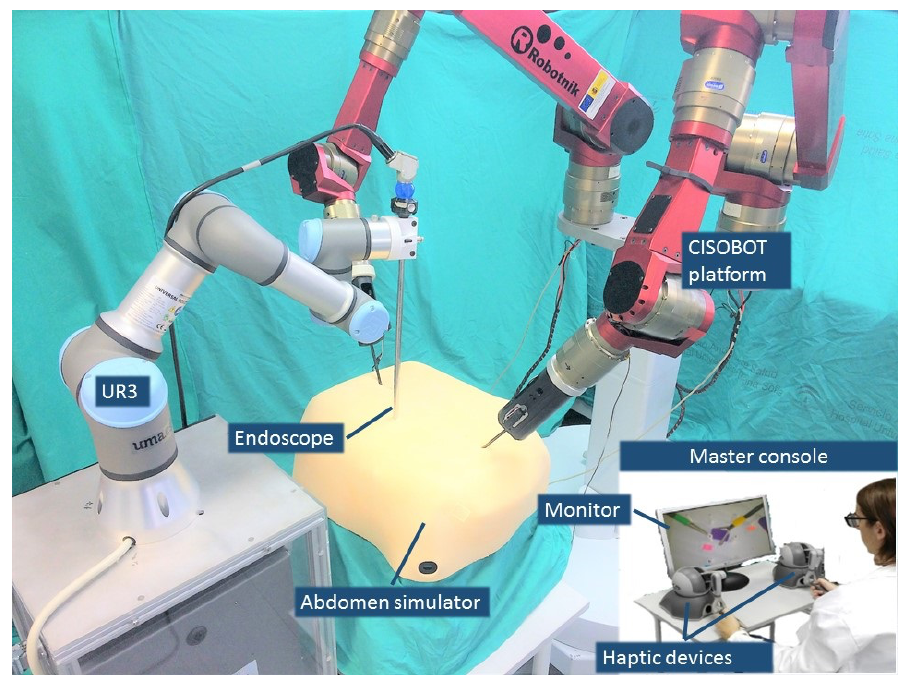
Figure 3. Experimental surgical robotic platform. It was composed of a teleoperation master console, an endoscope that was handled by a UR3 robot, and the CISOBOT platform.